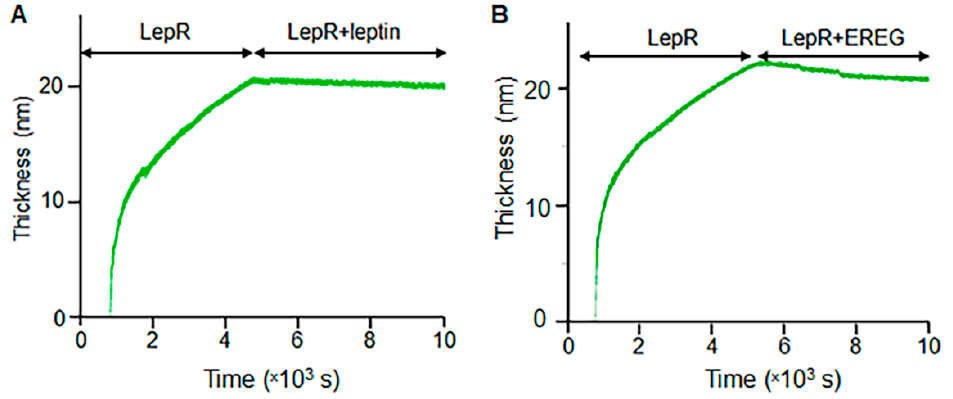
Figure 5. Kinetics of the changes in LepR film thickness in the presence of leptin ( A ) or EREG ( B ). Film thickness was measured using QCM and quantified based on the binding kinetics to a gold